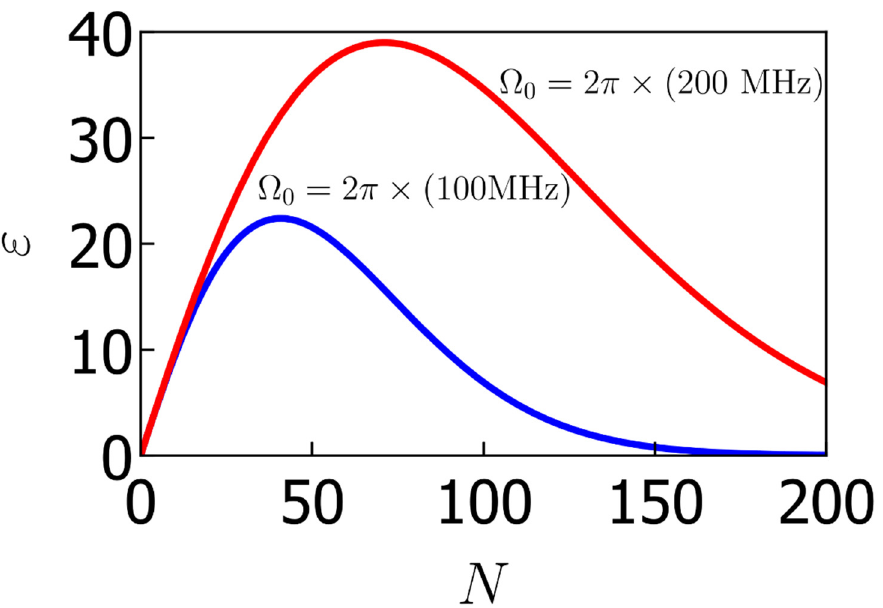
Figure 11. Improvement factor ε as a function of N = k t / k eff , with the effective Rabi frequency ε = Figure 11. Improvement factor as a function of eff / t N k , with the effective Rabi frequency Ω 0 = 2 π × ( 200 MHz ) (red) and Ω 0 = 2 π × ( 100 MHz ) (blue) when only considering the effect of the × imperfection of the π -pulses. For both curves, the improvement factor ε goes up first as N increases, (red) and (blue) when only considering the then it reaches a maximum value, and finally goes down. The maximum improvement is also effect of the imperfection of the π -pulses. For both curves, the improvement factor ε goes up first as enhanced as Ω 0 increases. ε reaches a maximum value of 39 for N = 69 with Ω 0 = 2 π × ( 200 MHz ) N increases, then it reaches a maximum value, and finally goes down. The maximum improvement is also enhanced as